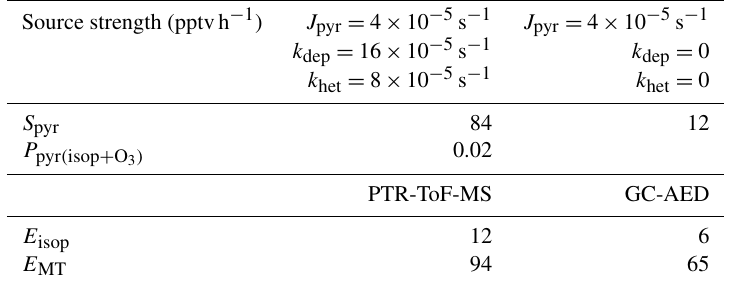
Table 1. Calculated source strength of pyruvic acid ( S pyr ), production rate from isoprene + O 3 ( P pyr ( isop + O ( E isop ) and monoterpenes ( E MT ) at solar